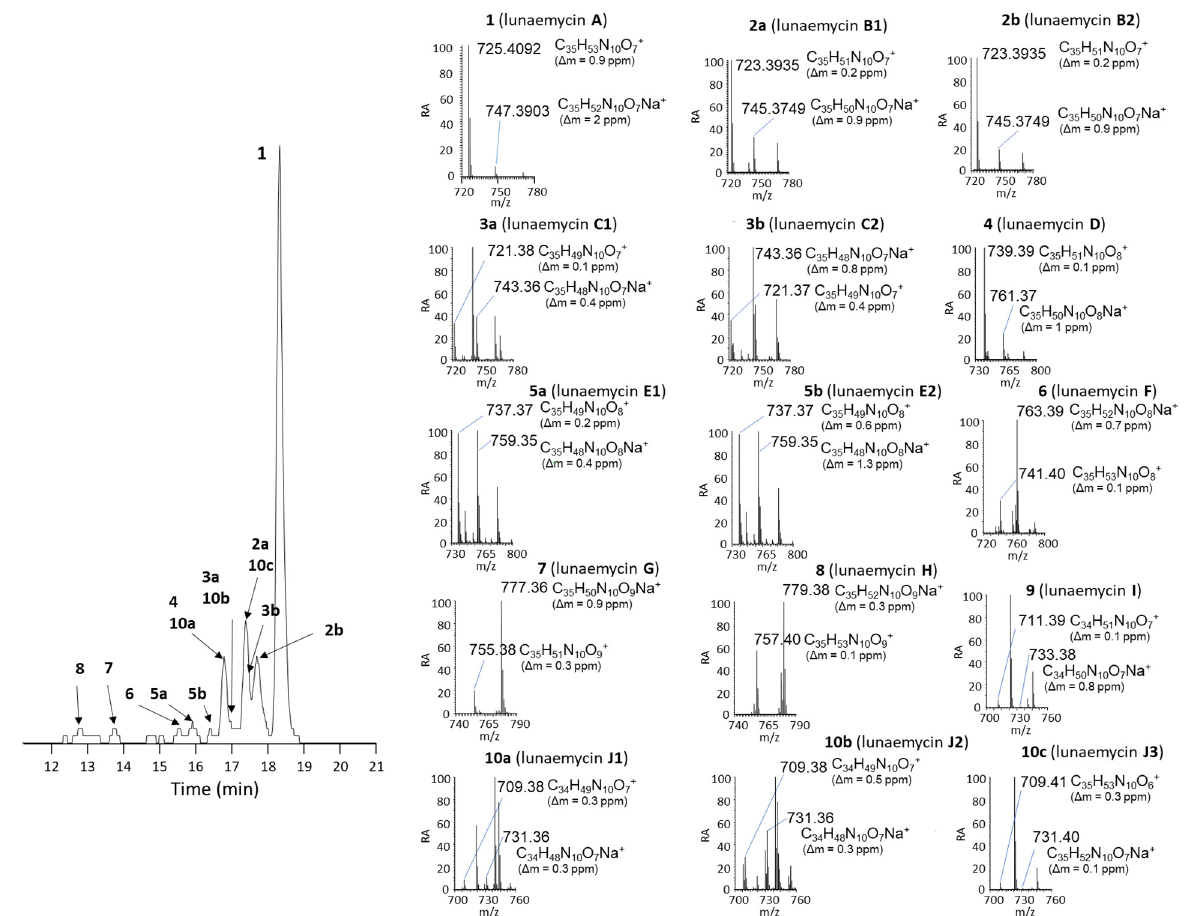
Figure 7. UPLC-HRMS chromatograms and mass spectra of lunaemycins . Left panel: Extracted ion chromatogram (EIC) with m/z signals ranging from 700 to 800 Da from the full extracts of S . lunaelactis MM109 T grown on ISP7 medium. Right panels: HRMS-predicted molecular formula of compound 1 to 10c (for both the proton and the sodium adducts) associated with the main signal detected in the EIC displayed on the left panel. Table 3. Lunaemycins produced by S. lunaelactis MM109 T and MM37.